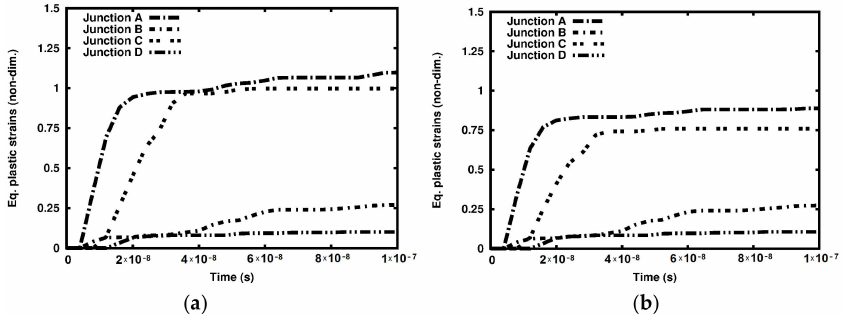
Figure 11. Equivalent plastic strain variations at the junctions: ( a ) Adiabatic solution; ( b ) coupled solution.